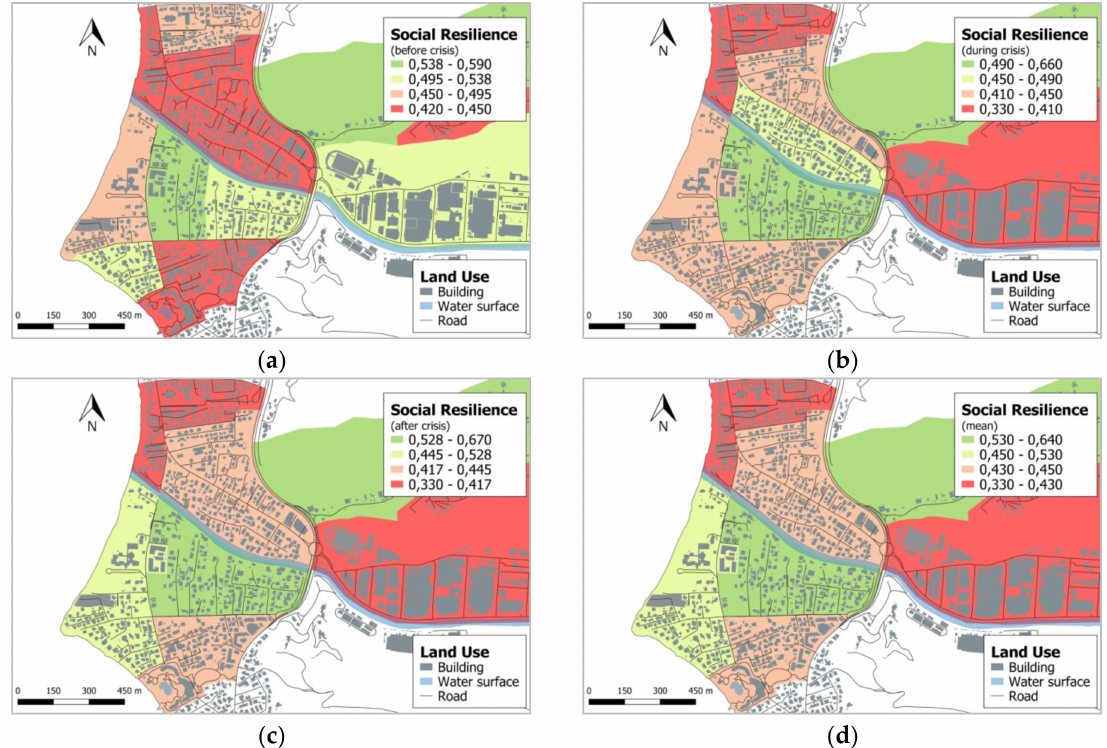
Figure 3. Social resilience of the Punaruu Valley characterized on the basis of social resilience indicators: ( a ) before, ( b ) during, and ( c ) after a disturbance. ( d ) Average social